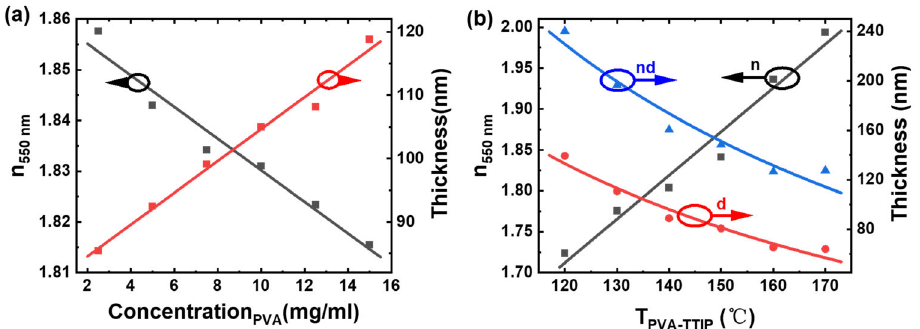
Figure 2. ( a ) The thickness (red curve) and refractive index (black curve) of the hybrid material PT (14.4%) films with PVA content at the wavelength of 550 nm. ( b ) The effective refractive index (n), the optical path length (nd), and the thickness (d) of the hybrid film PT (14.4%) spin-coated on glass substrates after annealing at different temperatures.